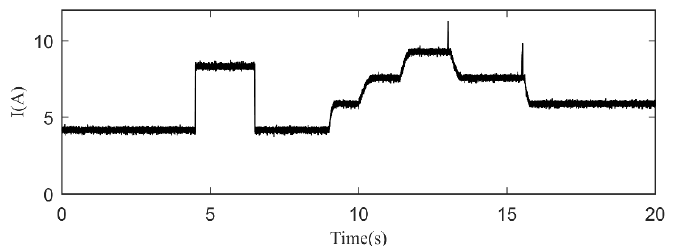
Figure 20. Experimental signal diagram.